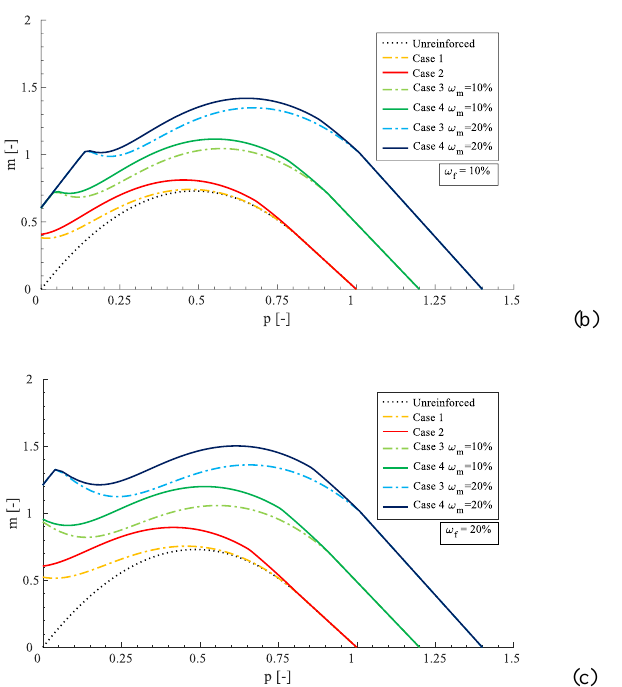
Figure 7. The p–m interaction domains for all 4 cases: ( a ) ω f is fixed (5%); ( b ) ω f is fixed (10%); ( c ) ω f is Figure 7. The p – m interaction domains for all 4 cases: ( a )  f is fixed (5%); (b )  f is fixed (10%); ( c )  f is fixed fixed (20%).